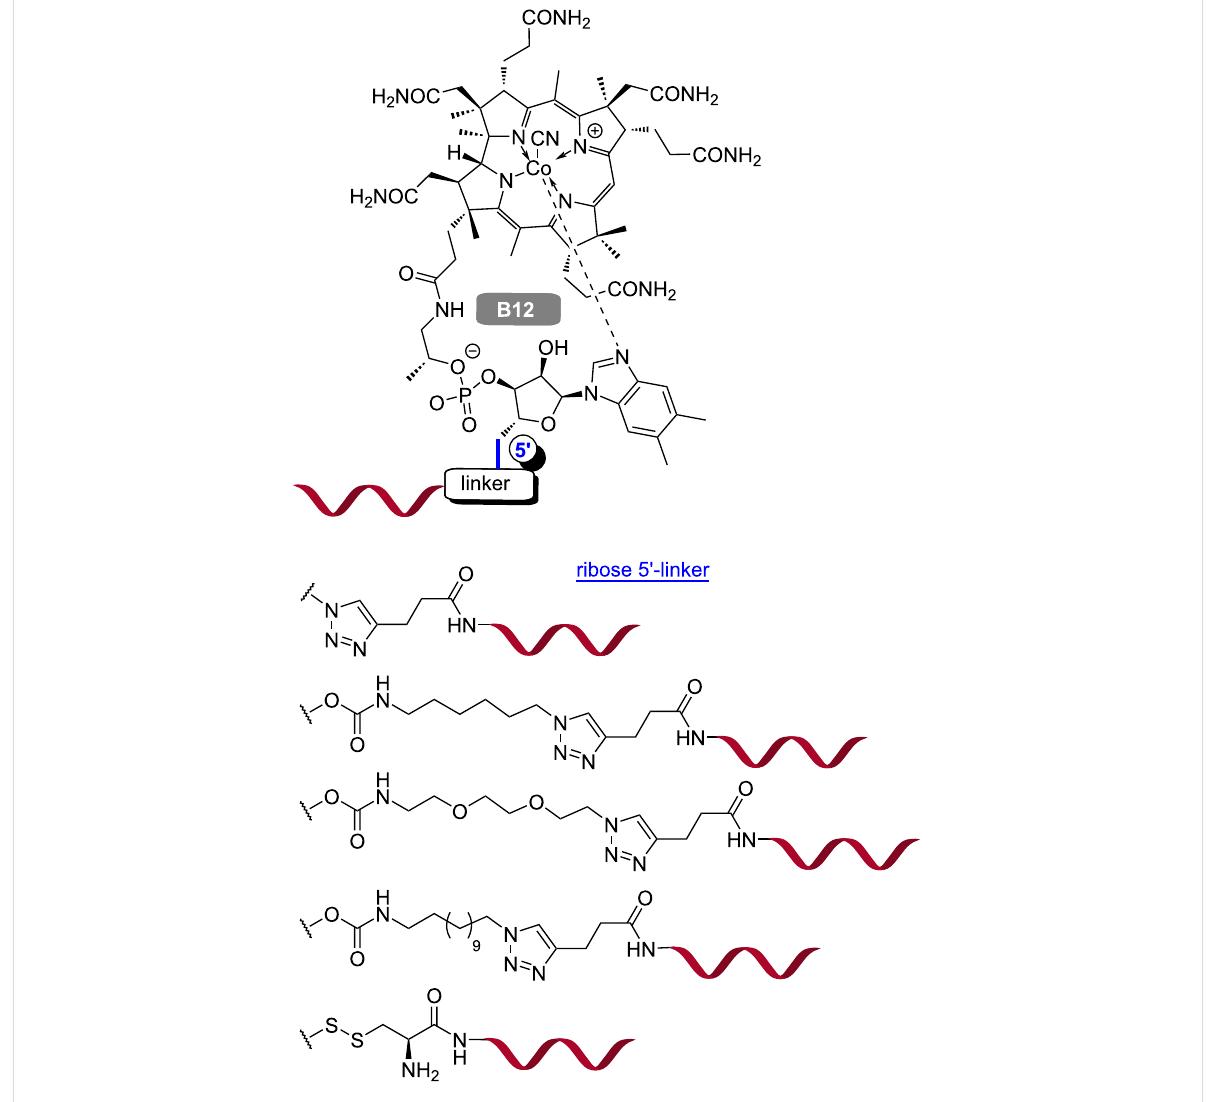
Figure 19: Vitamin B 12 –PNA conjugates with different